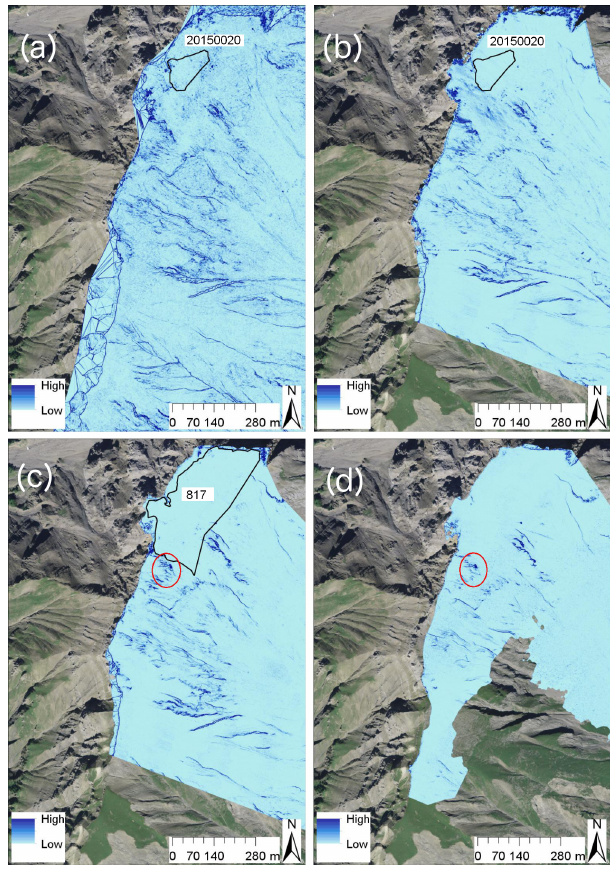
Figure 9. Surface roughness of (a) the summer terrain, (b) the win- ter terrain for the snow distribution of 8 December 2010, (c) the winter terrain for the snow distribution of 3 February 2015 and (d) the winter terrain for the snow distribution of 8 March 2006. In black, the outlines of avalanche release areas at CB2 are shown. The red circles show critical terrain features with different degrees of smoothing due to varying snow depth.